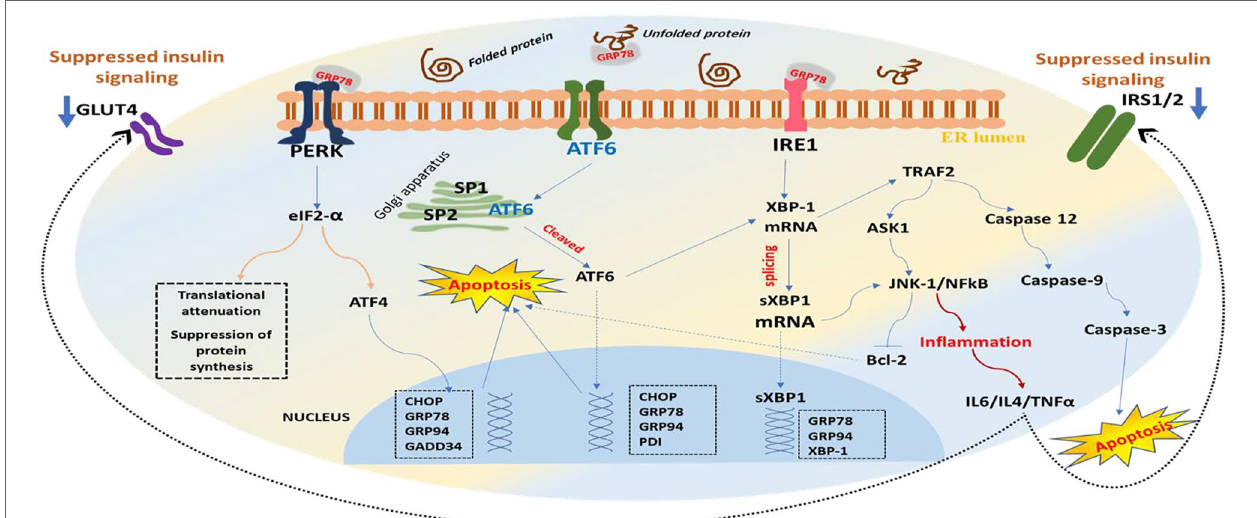
FIGURE 2 | A schematic representation of downstream effectors, target genes, and possible outcome in the ERS-activated UPR. Under ERS, dissociation of GRP78 from its luminal domain leads to oligomerization and autophosphorylation of PERK, ensuing its kinase and endoribonuclease activities. As a result, the α subunit of eukaryotic initiation factor 2 (eIF2) undergoes phosphorylation, resulting in translational attenuation characterized by a reduction in protein biosynthesis. Parallelly, this downstream phosphorylation of eIF2 leads to increased expression of ATF4 and translocation into the nucleus where it binds to the UPR element (UPRE) resulting in transcriptional modification of UPR target genes including the proapoptotic transcription factor, C homologous protein (CHOP), GRP78, GRP94, and GADD34, while attenuating global translational process, but PERK phosphorylation also inhibits transcription of I kappa B alpha (I κ B α ), leading to hyperactivation of NF- κ B and increased production of inflammatory cytokines ( Figure 4 ). On the other hand, ERS leads to autophosphorylation of IRE-1, leading to excision and splicing of its substrate, XBP1 mRNA. Consequently, this results in spliced XBP1 protein (sXBP1), which translocates into the nucleus, and this will upregulate genes for protein folding enzymes secretion and ER-associated protein degradation (ERAD). Noteworthy, the ATF6 is activated following PERK and prior to IRE1. The GRP78 dissociates from ATF6 and recruited to luminal protein aggregates resulting in translocation of ATF6’s cytosolic fraction to the Golgi, where it is spliced and proteolyzed by site one proteases (S1Ps) and site two proteases (S2Ps). Eventually, this leads to the release of the cytosolic domain of ATF6 and entry into the nucleus where it sequesters with the ERS response element (ERSE) resulting in the activation of UPR target genes including XBP1, CHOP, and GRP78/ BiP, GRP94, PDI. However, chronic ERS, which may result from persistent perturbation of the ER, can lead to malfunction within the network and failure of the UPR adaptive system. And as a result, the PERK-mediated post-translational attenuation is inhibited and further accumulations of unfolded protein aggregates, leading to initiation of C homologous protein (CHOP)-mediated apoptotic deaths of the